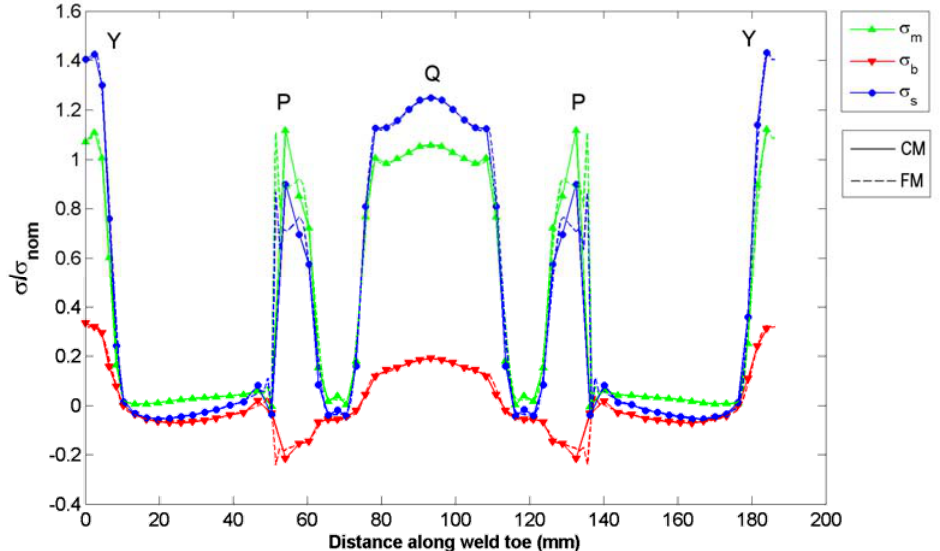
Figure 8: Structural stress and its components along the fillet weld of type “T” specimen. CM: coarse mesh, FM: fine